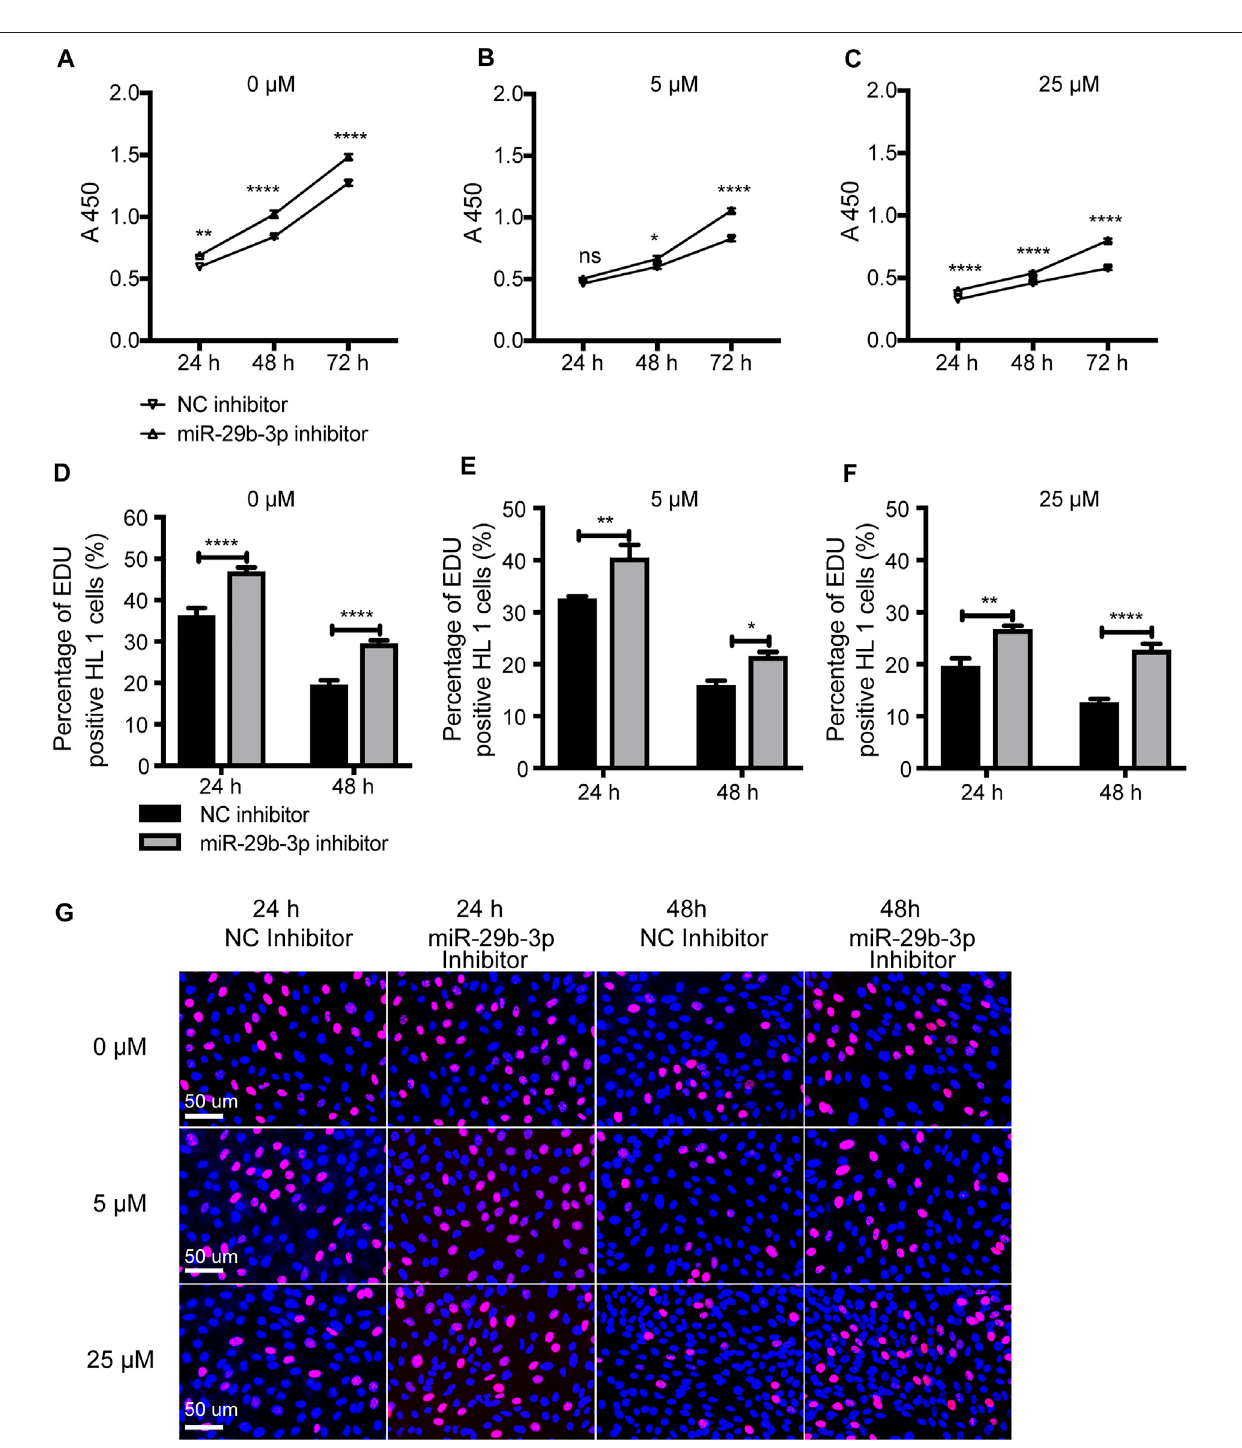
FIGURE 8 | The proliferation ability of hypomethylated cardiomyocytes transfected with miR-29b-3p inhibitor. (A – C) Cell proliferation ability detected by a CCK-8 assay at 24, 48 and 72 h (D – F) The cell proliferation ability detected by an EdU incorporation assay at 24, 48 and 72 h. (G) Representative images of HL1 cells stained withEdUandHoechst(0 μ M,5 μ M,and25 µMrepresent3concentrationsof5-azacytidine;miR-29b-3pinhibitorvs.NCinhibitor, ns notsigni fi cant,* p < 0.05,** p < 0.01, *** p < 0.001, and **** p < 0.0001).